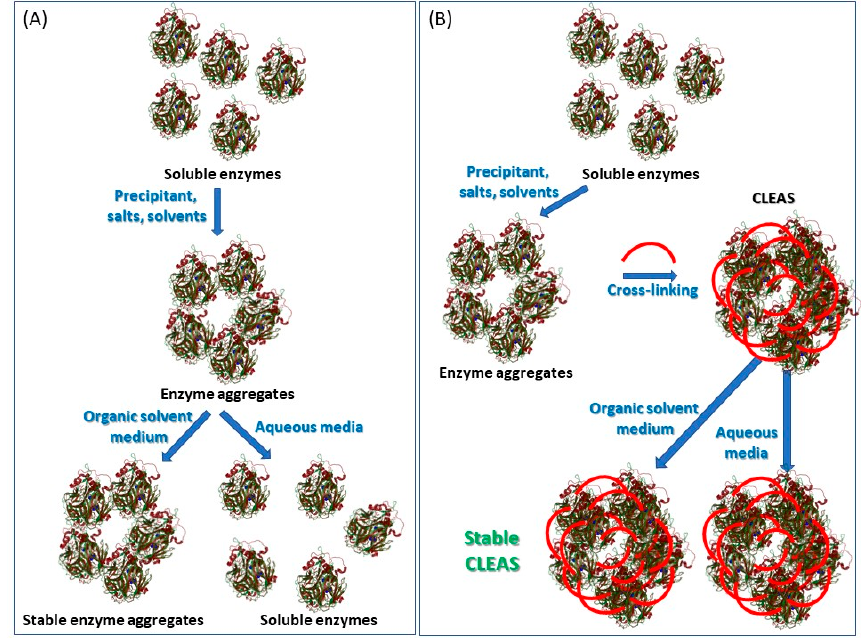
Figure 9. ( A ) formation and redissolution of enzyme aggregates, ( B ) stable CLEA